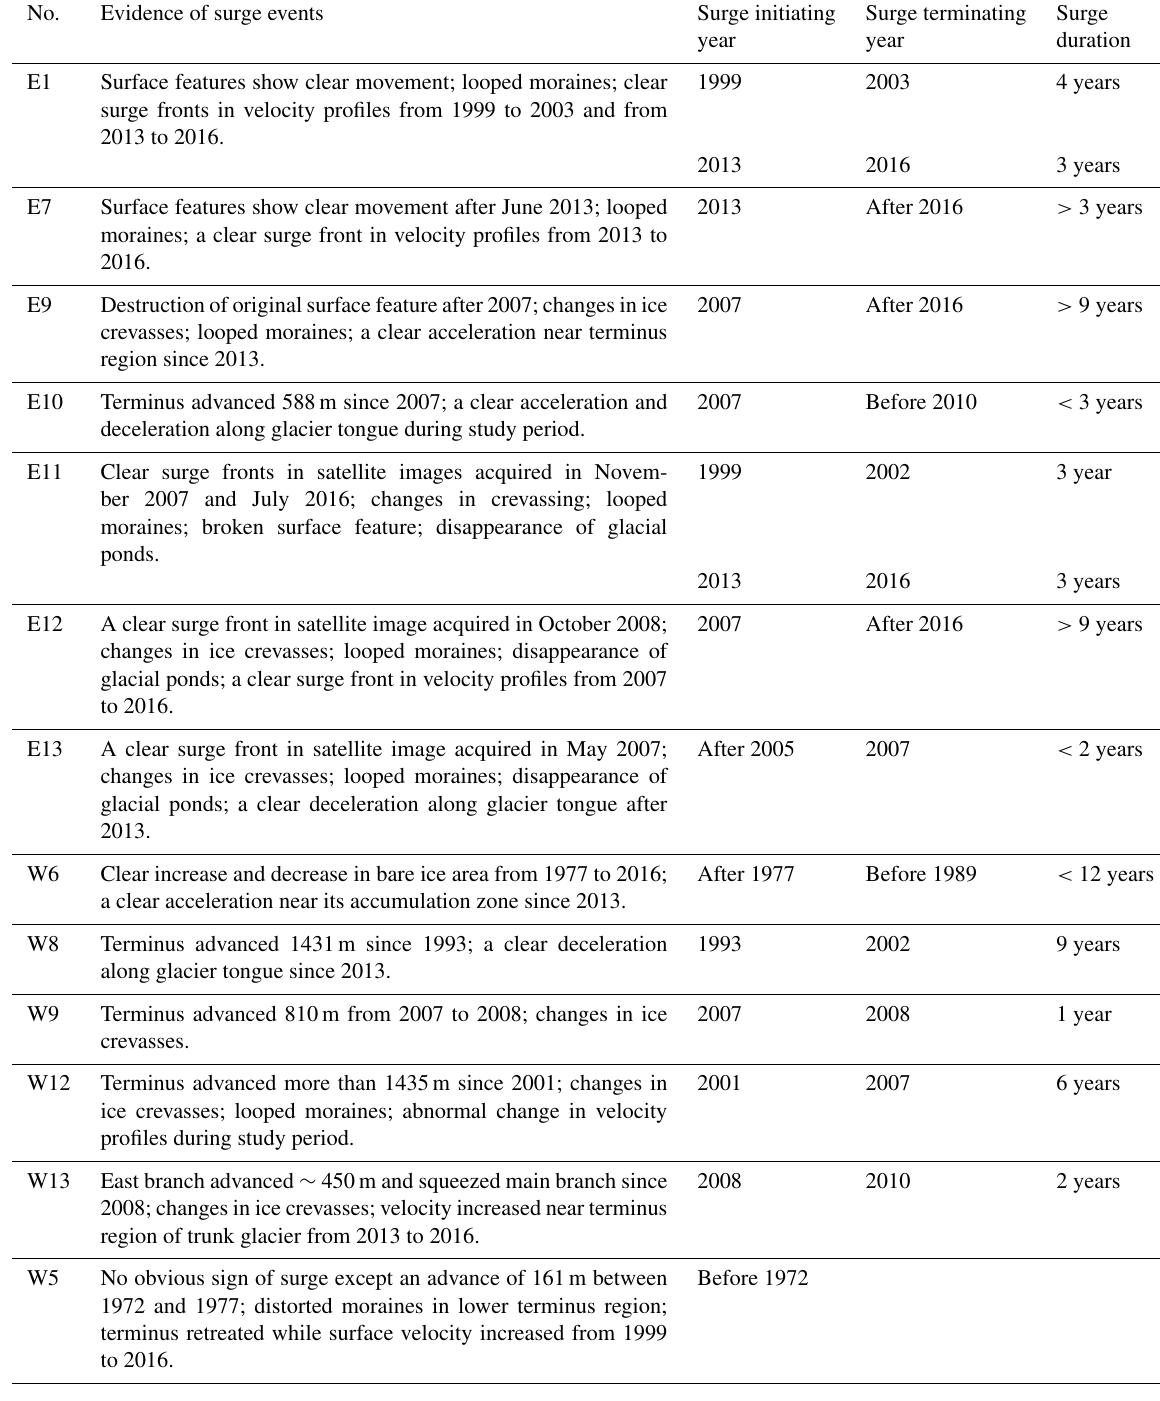
Table 2. Detailed information of each surge-type glacier in this study including evidence of each surge event, their initiating and terminating year, and their